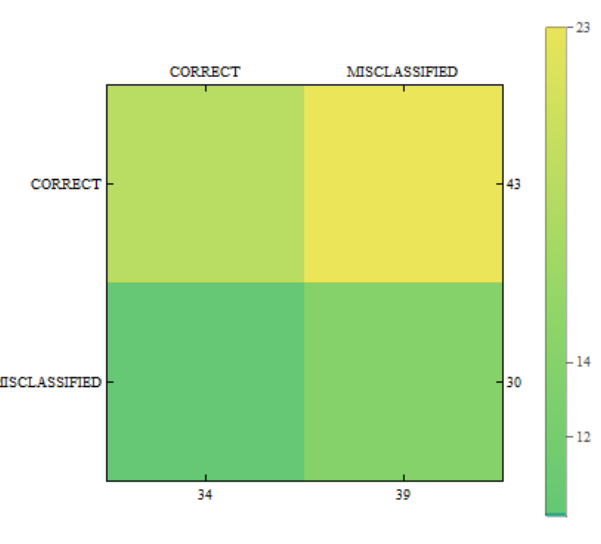
Figure 12. Confusion matrix for measurements obtained by the classifier using created images from the proposed method only.